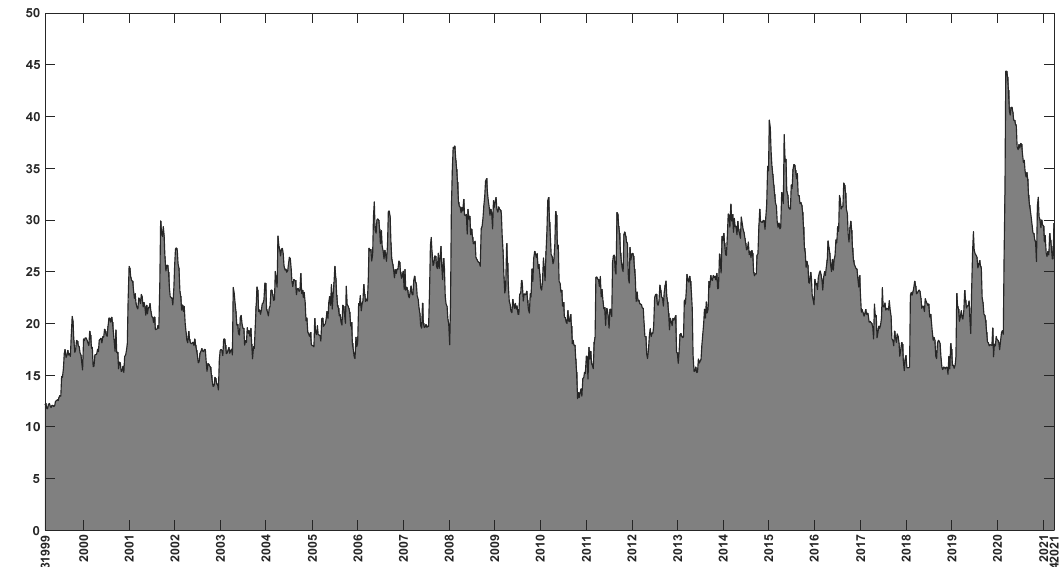
Figure 2. Dynamic total connectedness for stress indicators of the Spanish financial market. Note: The predictive horizon for the underlying variance decomposition is 10 weeks.